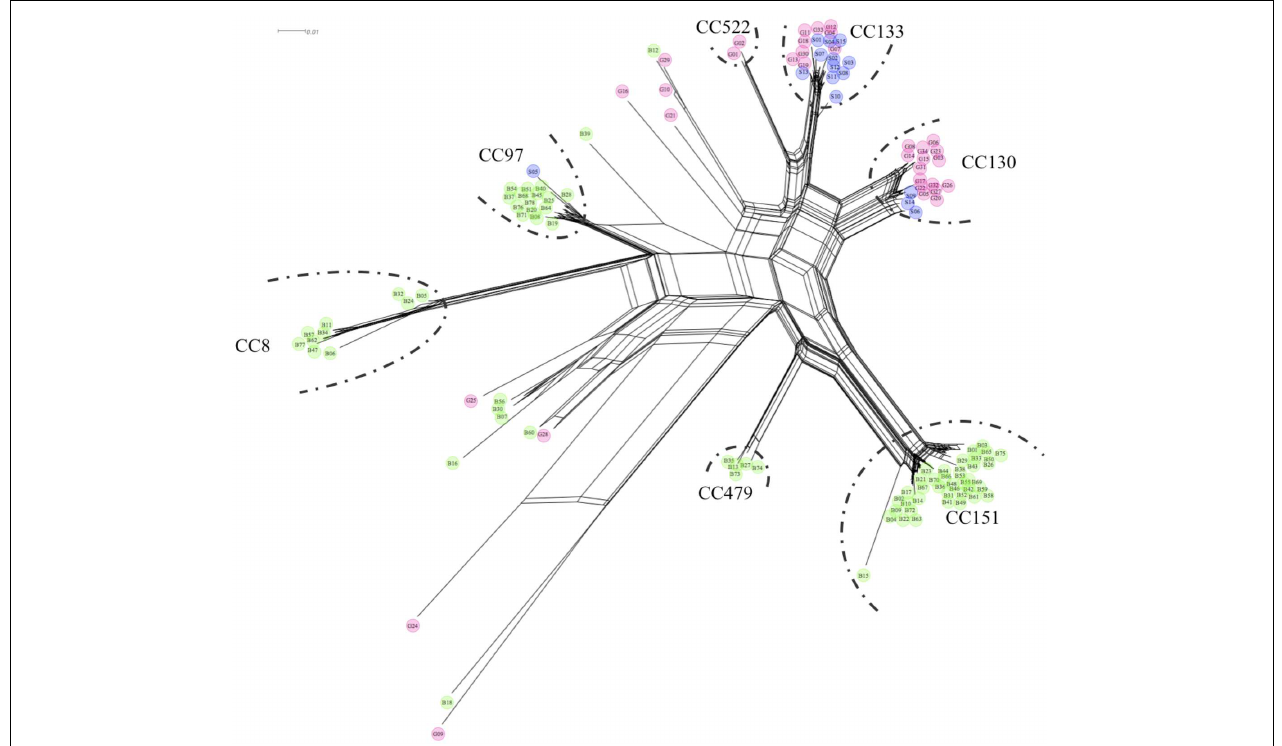
FIGURE 2 | The SplitsTree illustrates similarities between virulence and resistance gene profiles of goat (G), sheep (S), and bovine (B) S. aureus isolates. The isolates grouped into clusters mainly based on assignment to CC. Isolates from small ruminants form a distinct population and were mainly found in the clusters of CC130 and CC133. Bovine isolates were predominant in clusters CC8, CC97, CC151, CC479.